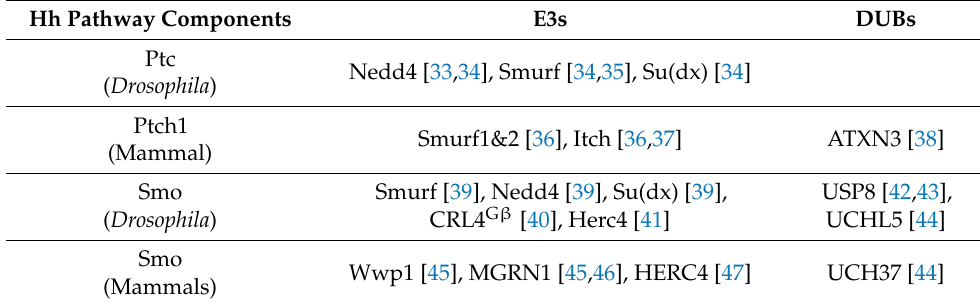
Table 1. E3 ligases and DUBs involved in Hh pathway